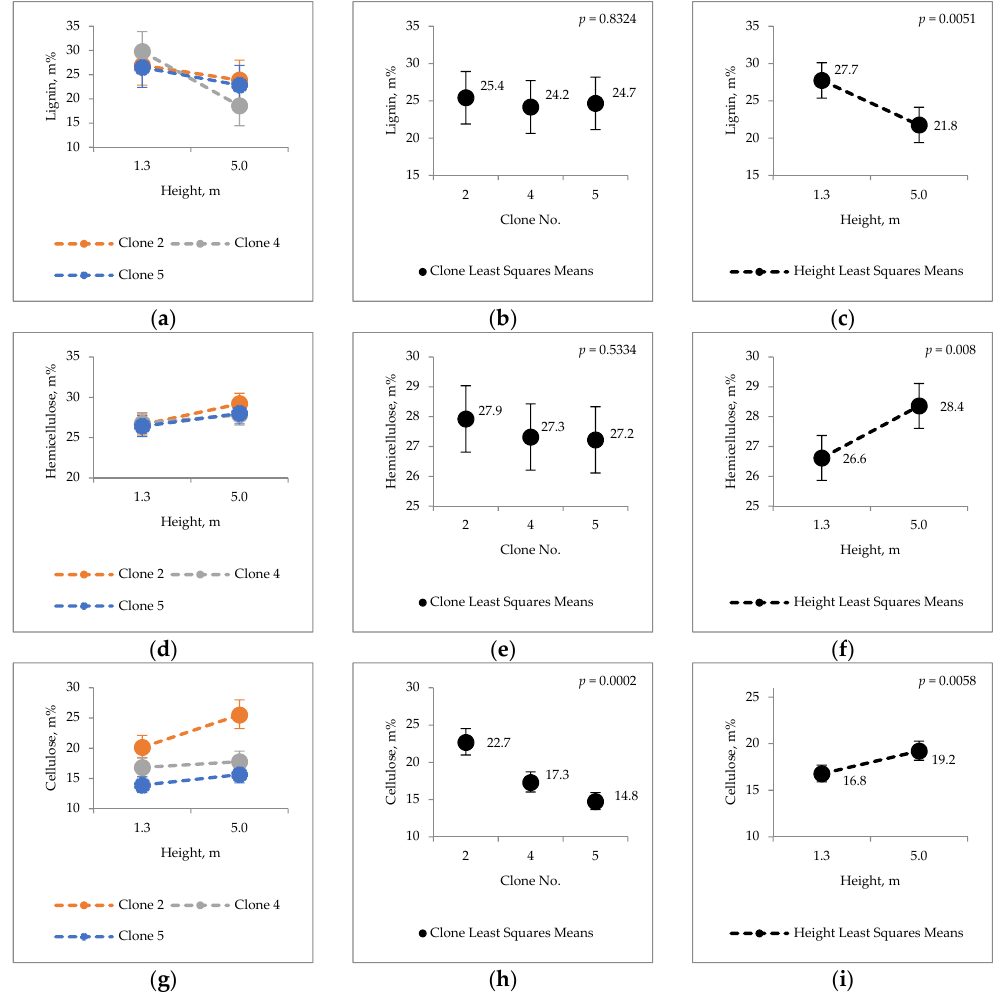
Figure 1. Content of lignin ( a – c ); hemicellulose ( d – f ); and cellulose ( g – i ) in the bark of hybrid aspen.